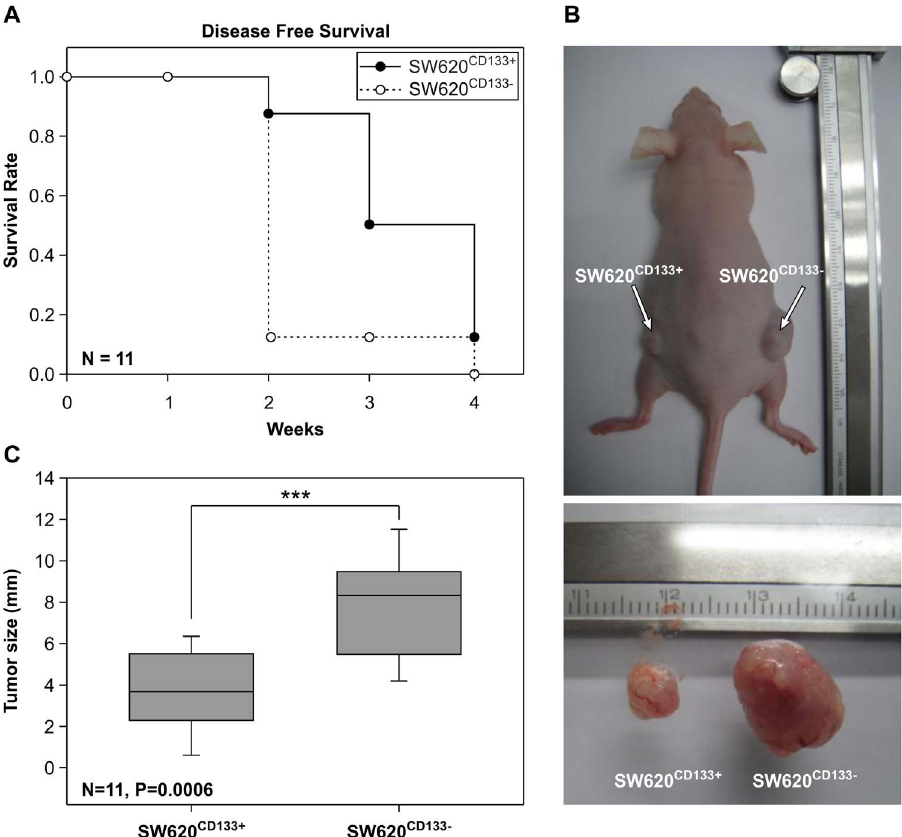
Figure 3. Comparison of tumorigenicity of SW620 CD133 + and SW620 CD133 2 cells in nude mice. Purified SW620 CD133 + and SW620 CD133 2 cells were injected subcutaneously into nude mice. (A) Filled and unfilled circles refer to the disease-free survival rate of the SW620 CD133 + and SW620 CD133 2 cells, respectively, N=11. (B) Upper photograph shows tumor formation due to SW620 CD133 + cell inoculation on the left side and due to SW620 CD133 2 cell inoculation on the right side. Lower photograph shows the sizes of the SW620 CD133 + and SW620 CD133 2 tumors. (C) Chart showing the mean diameters of the SW620 CD133 + (3.8 mm, SD=2.1) and SW620 CD133 2 (8.1 mm, SD=2.6) tumors, N=11, P=0.0006.